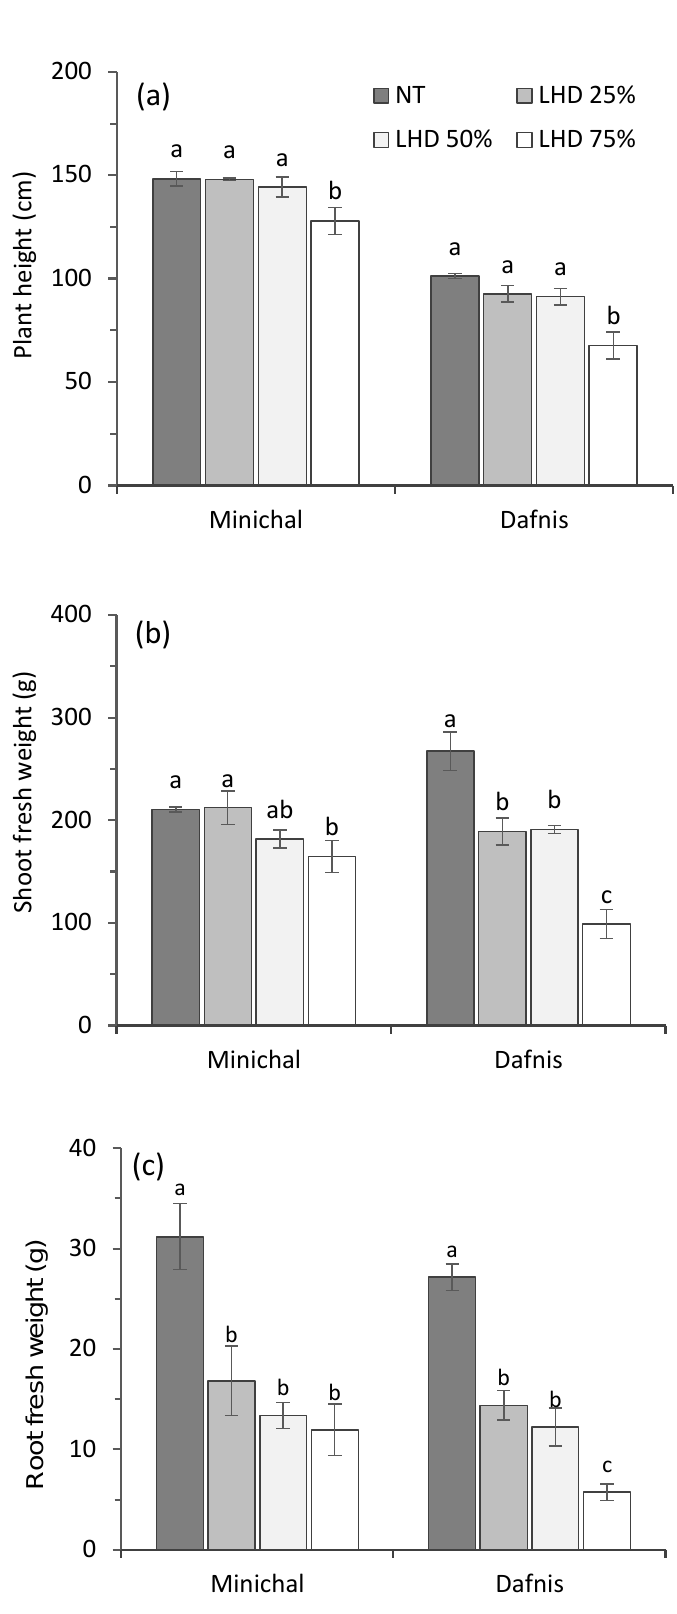
Figure 7. Effect of leaf heat damage levels on plant height ( a ), shoot fresh weight ( b ) and root fresh weight ( c ) in tomato cultivars. Vertical bars represent ± SE (n = 3). Values with different letters indicate significant differences at p ≤